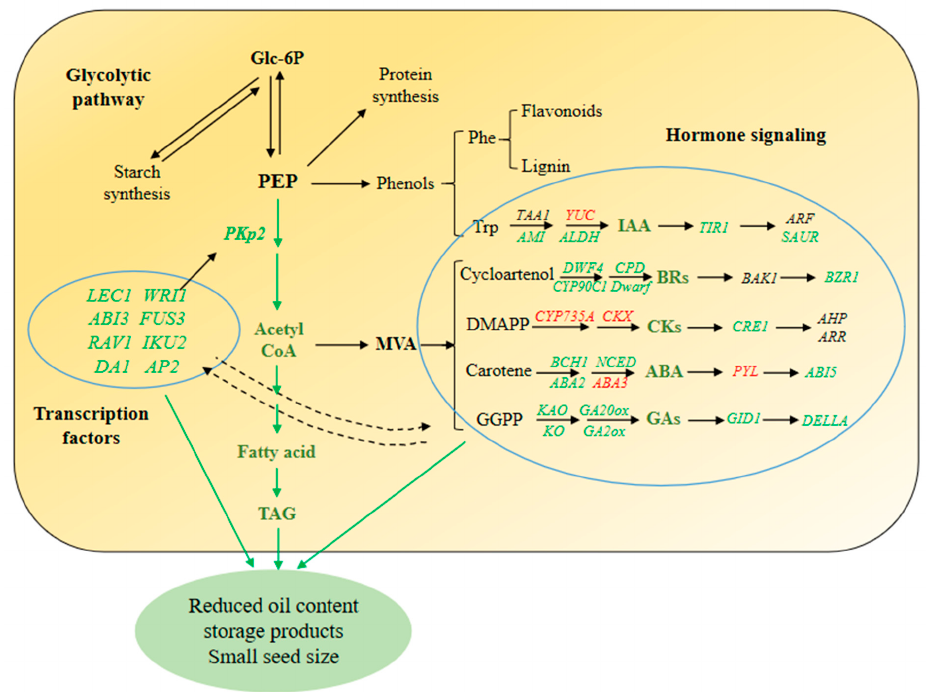
Figure 9. The regulatory model underlying small-seed phenotype in ssm1 mutant. Glc-6P, D-Glucose 1-phosphate; PEP, Phosphoenol pyruvate; TAG, Triglyceride; Phe, Phenylalanine; Trp, Tyrosine; MVA, Mevalonic acid; DMAPP, Dimethylallyl diphosphate; GGPP, Geranylgeranyl diphosphate. Genes, metabolites, or arrows with green color indicate down-regulated expressions or reduced contents; those with red color indicate up-regulated expressions or increased contents.